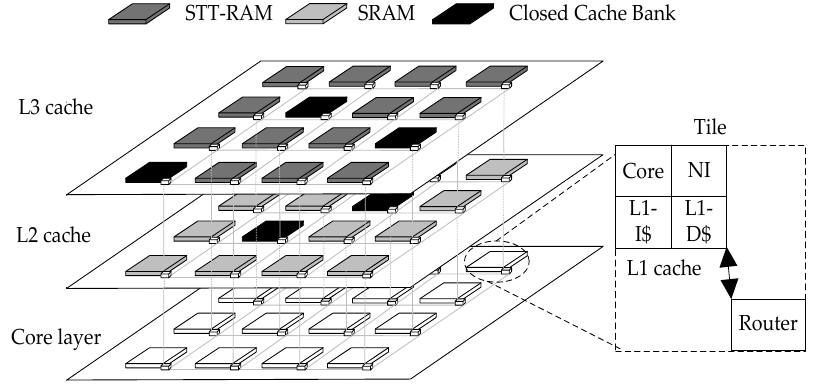
Figure 1. The target 3D Chip-Multiprocessor (CMP) architecture.